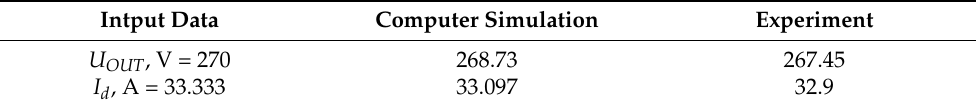
Table 3. Output data and obtained results from simulation and experiment for full-bridge transistor resonant inverter with reverse diodes.